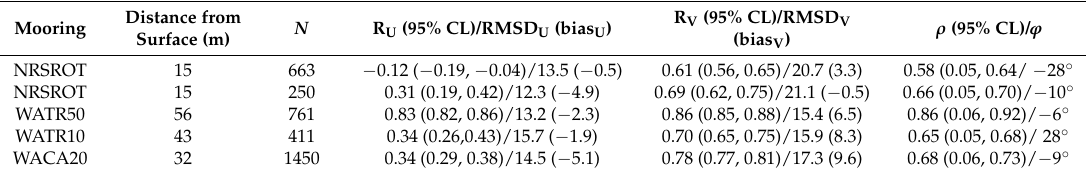
Table 4. Comparison between WERA surface HFR currents and subsurface current data at the mooring locations. Units for RMSD and phase angle are cm/s and degrees, respectively. Positive (negative) values for phase angle indicate that surface HFR currents are rotated counterclockwise (clockwise) from subsurface currents.